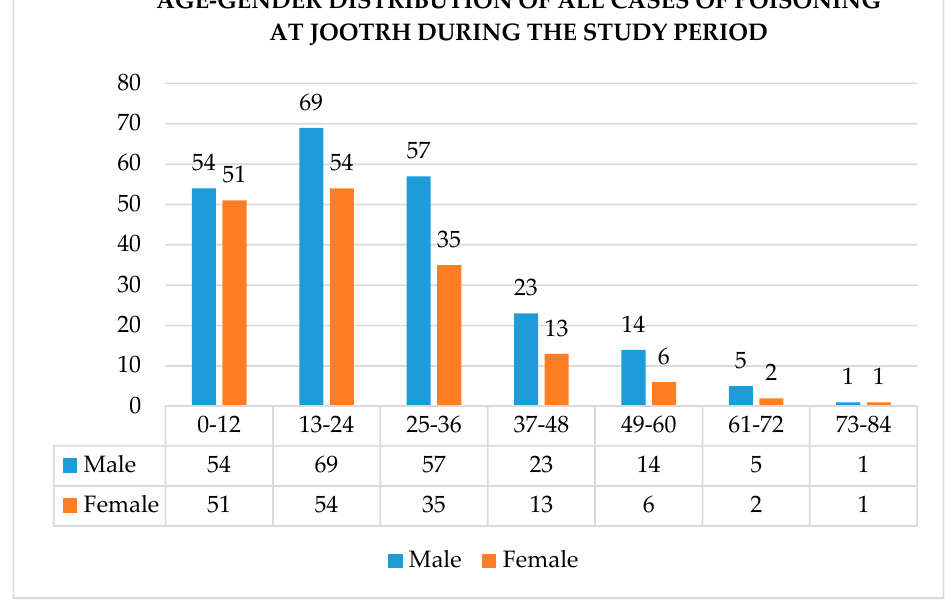
Figure 1. Age–gender distribution of cases of poisoning at JOOTRH during the study period.